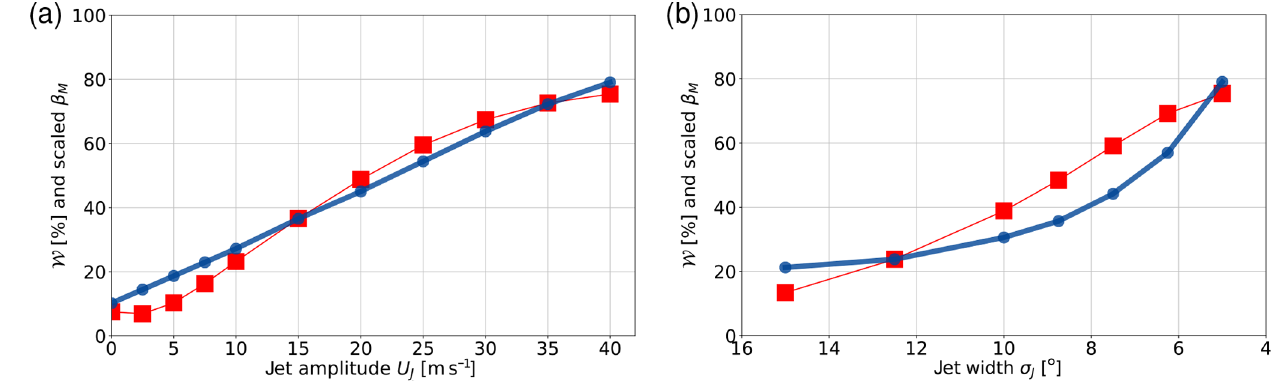
Figure 8. Same as Fig. 6, except that here the solid blue line represents the non-dimensionalized β M (see text for details).